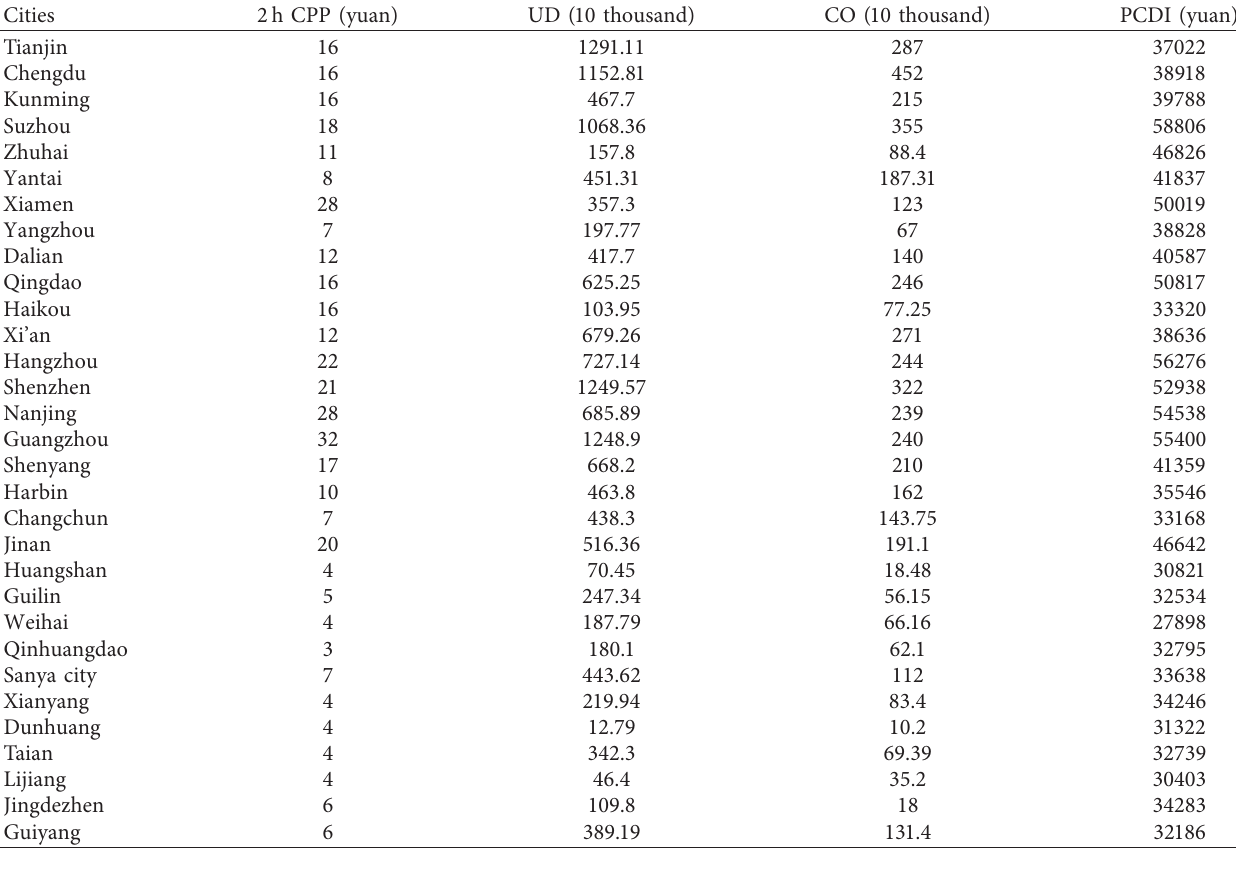
Table 3: The curb parking price in the core areas in TCs